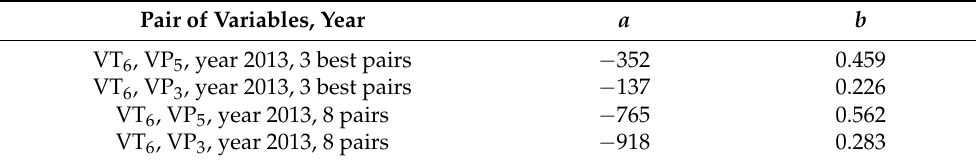
Table 17. Parameters of the investigated model for the Pozna´n